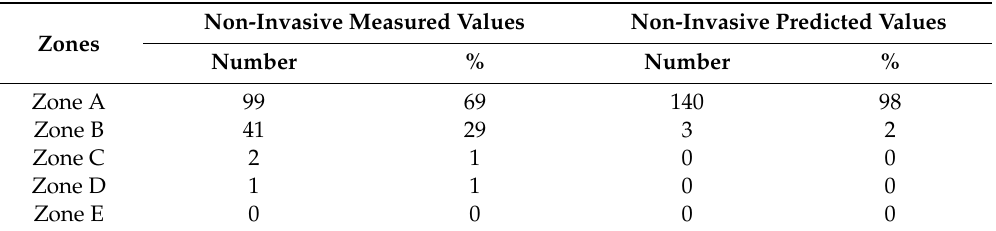
Table 13. CEGA plot summary for dataset 2.